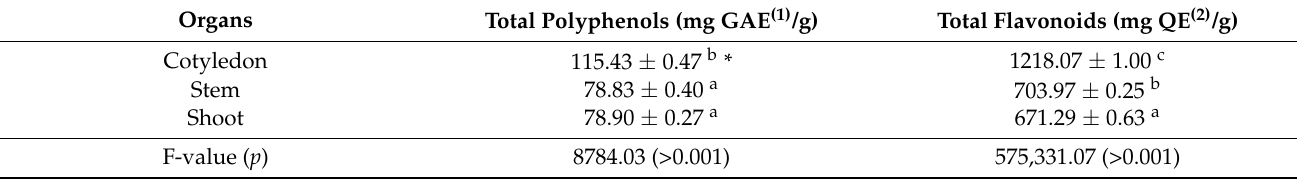
Table 1. Contents of total polyphenols and total flavonoids of ethanol extracts from different organs of ice plant. ( M. crystallinum